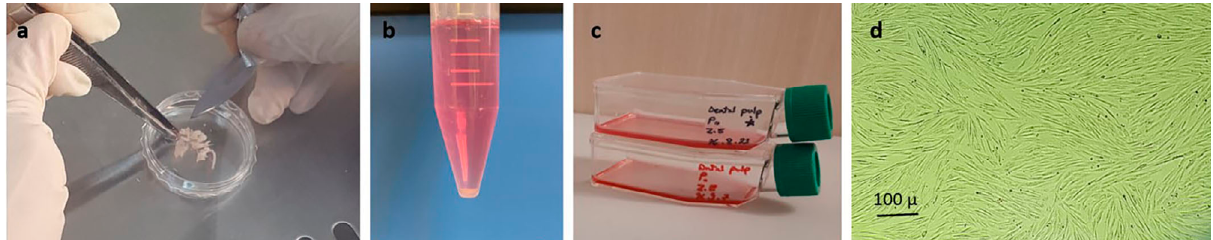
Figure 1- a. Pulpal tissues were rinsed by penicillin/streptomycin-containing phosphate-buffer solution (PBS) and sectioned into several pieces. Pulpal tissues were placed in collagenase I solution for 30 minutes and incubated at 37ºC and 5% CO2 with 100% humidity. Then, to neutralize collagenase solution, standard culture solution containing high-glucose DMEM, penicillin/streptomycin, 15% fetal bovine saline and fungizone were added and centrifuged at 1500 rpm for 10 minutes. b. Centrifuged to obtain cellular pellet in the falcon. c, d.